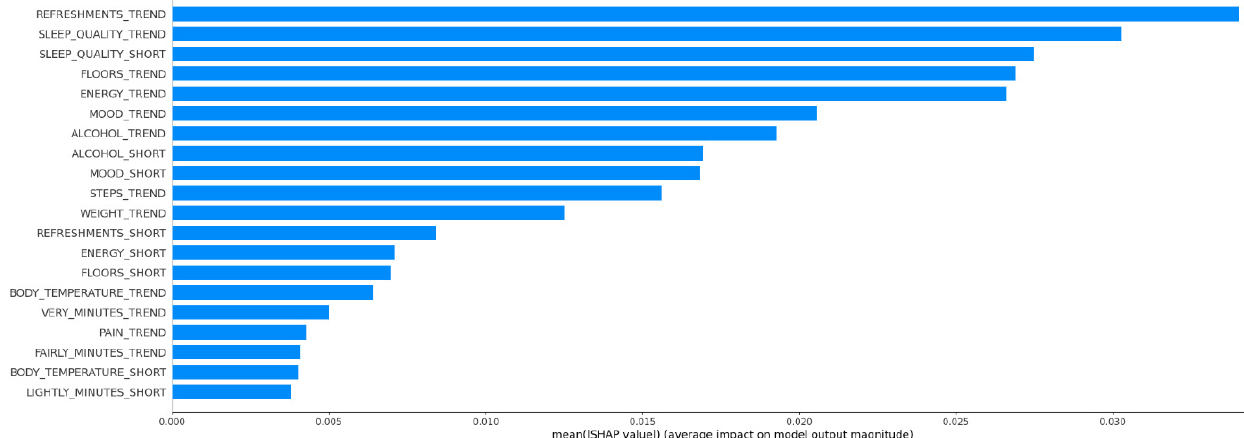
Figure 7. Average impact of feature vector elements on health change predictions without utilizing previous health (20 most influential elements shown).